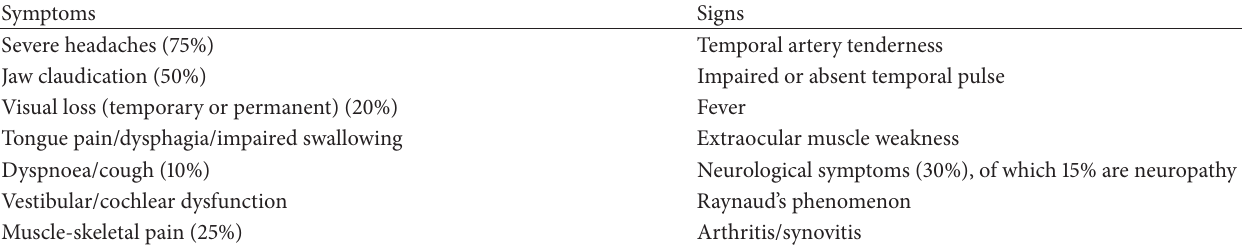
Table 1: Clinical characteristics of GCA; percentage of patients presenting the indicated